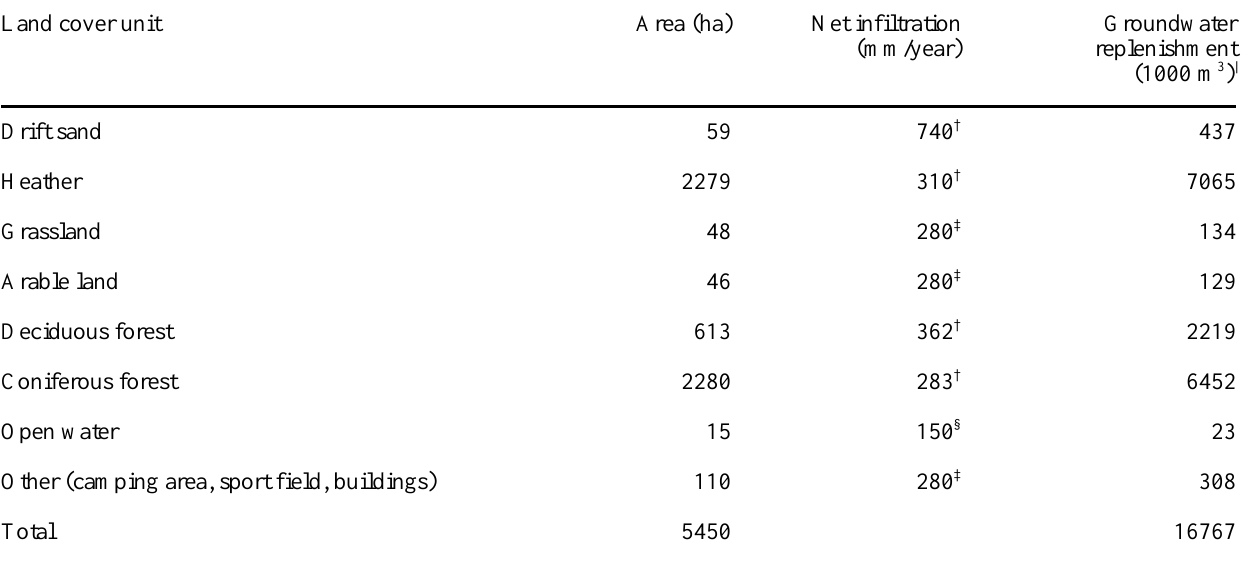
Table 1 . Groundwater replenishment in the Hoge